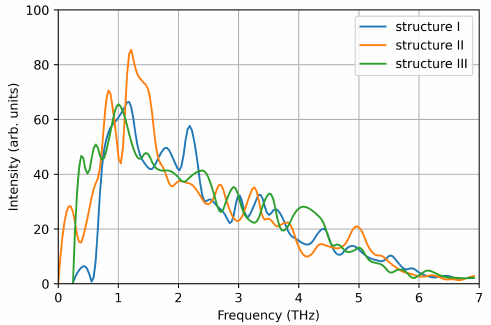
Figure 7. Vibrational density of states computed from the velocity auto-correlation function in VASP